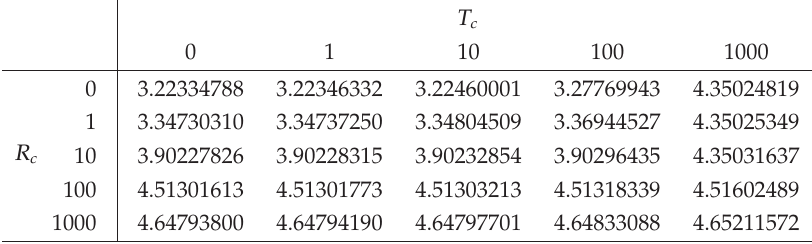
Table 5.3 . Values of coe ffi cients λ 2 for a beam with both ends and the intermediate point elastically restrained against rotation and translation.